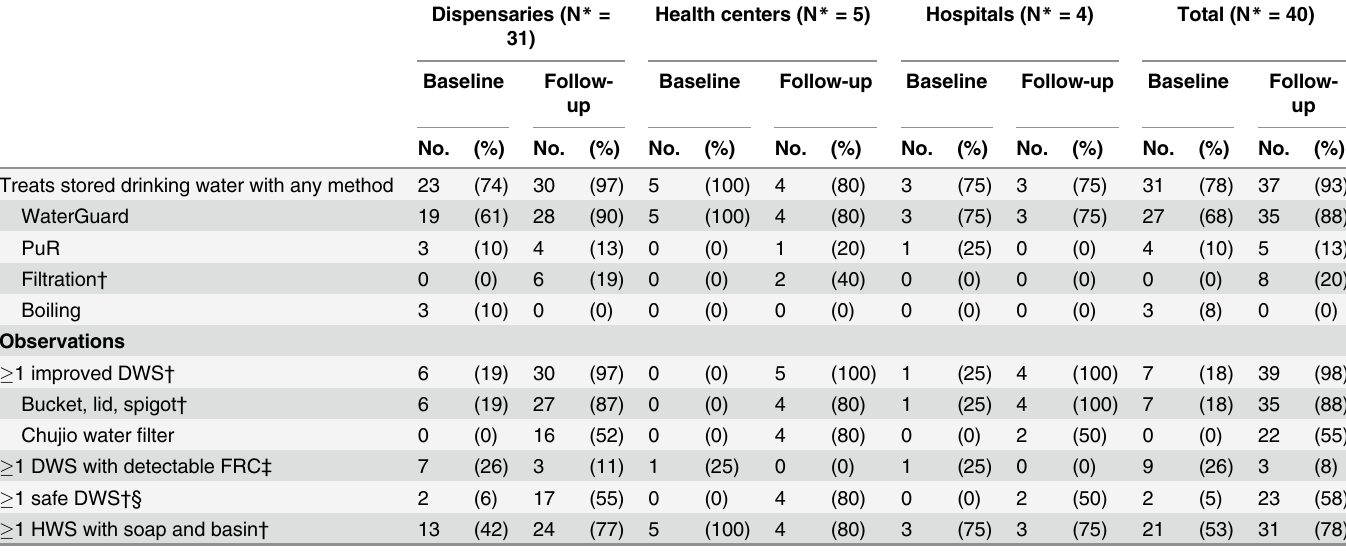
Table 1. Drinking water and hand washing observations at 40 health facilities at baseline and follow-up, western Kenya, 2011 and